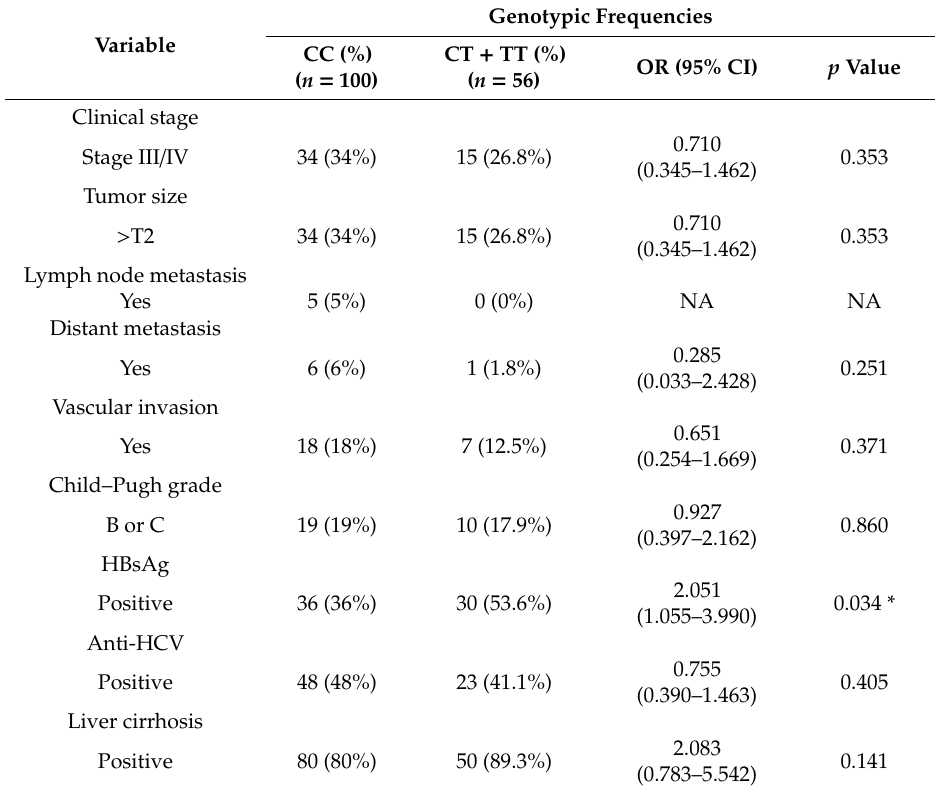
Table 6. Odds ratio (OR) and 95% confidence interval (CI) of clinical status and MALAT1 rs3200401 genotypic frequencies in hepatocellular carcinoma patients among